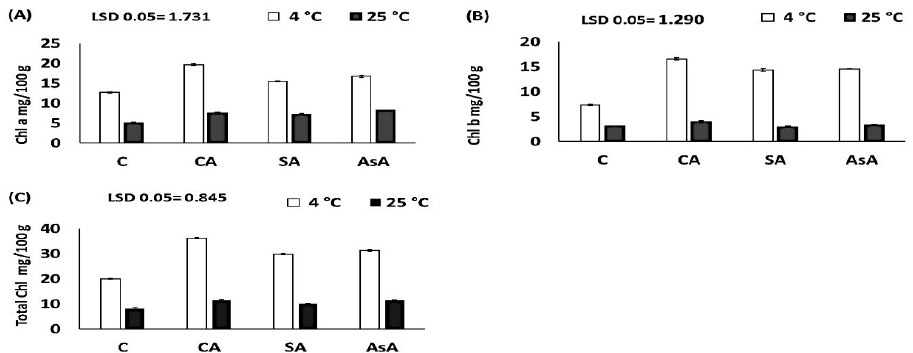
Figure 13. Effects of bio-stimulants B, control (C), citric acid (CA), salicylic acid (SA) and ascorbic acid (AsA) and storage temperature T (4 °C and 25 °C) on chlorophyll a ( A ), chlorophyll b ( B ) and total chlorophyll ( C ) of okra pods stored for 12 days. Error bars are the ±SD of the means of three biological replicates. LSD values ( p ≤ 0.005) for chlorophyll a ( A ): B = 0.29, T = 0.21, and B × T = 0.41. LSD values ( p ≤ 0.005) for chlorophyll b ( B ): B = 0.23, T = 0.16, and B × T = 0.33. LSD values ( p ≤ 0.05)